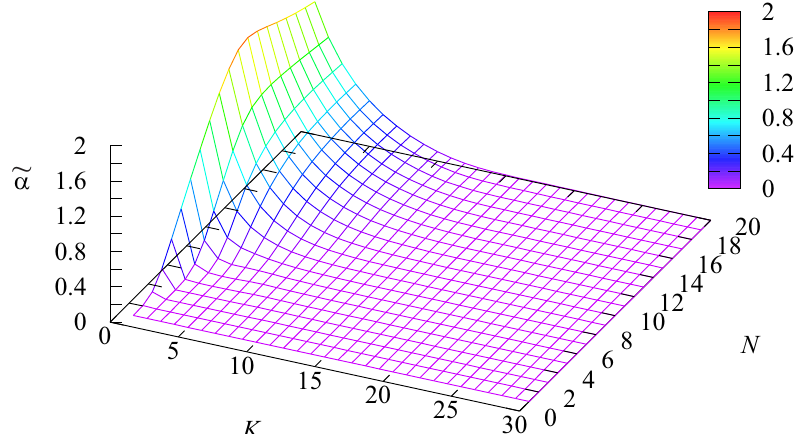
Figure 10. Dependence of the average transition intensity ˜ α of clients from the buffer of System 1 to the servers of System 2 on the parameters N and K .